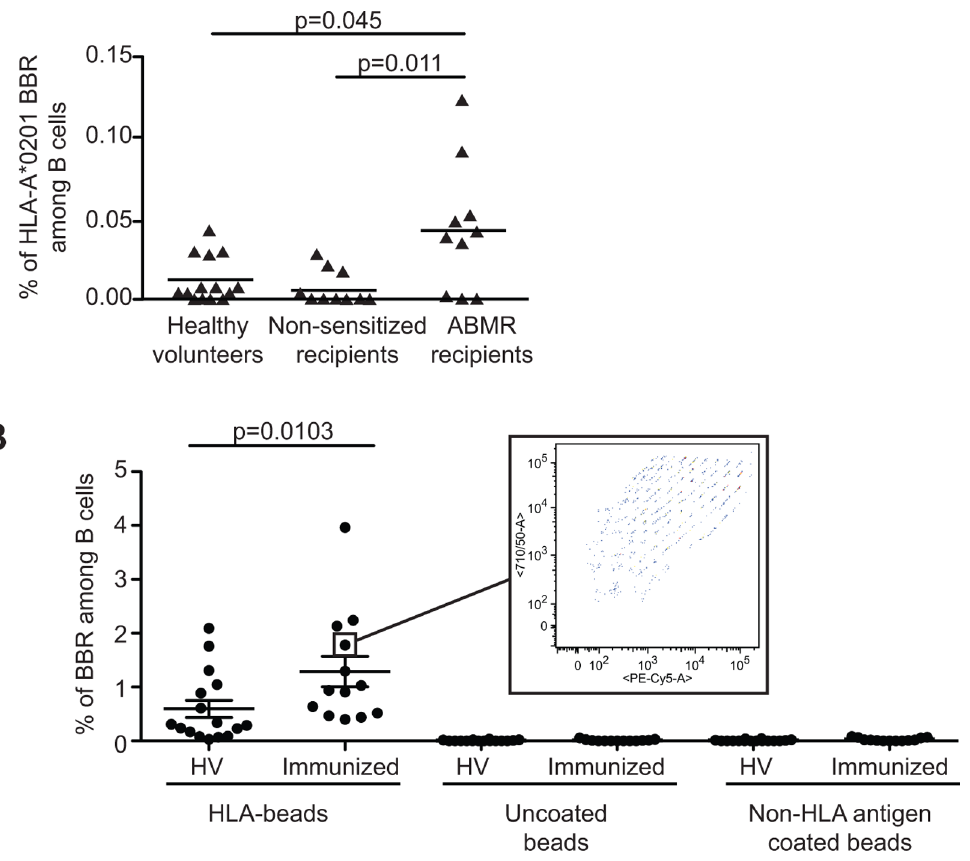
Figure 5. Enhanced frequency of anti-HLA B cell in immunized patients. A. Using single HLA-A*0201 coated beads, the frequency of B cells specific to HLA-A*0201 allele was assessed in the blood of sensitized transplant recipients with histologically proven antibody mediated rejection (ABMR; n=10), non-sensitized stable transplant recipients (n=9) and healthy volunteers (n=14). Sensitized patients exhibit a significant increase in the frequency of HLA-A*0201 specific B cells compared to non-sensitized patients and healthy volunteers. p value are mentioned (Kruskall-Wallis follow by a Dunn’s post hoc test) B. B cells bound to single HLA class I coated beads (HLA-beads), to negative control (NC) and positive control (PC) were analyzed in HV (n=16) and Immunized kidney recipients (n=13). NC and PC beads were included by the manufacture in the single HLA class I kit. According to the manufacture, NC beads are beads saturated with ovalbumin and PC beads are coated with human IgG1. A broad range of single HLA class I were recognized as shown in the insert, a pattern observed for B cells from all tested patients. p value is indicated (Mann-Whitney